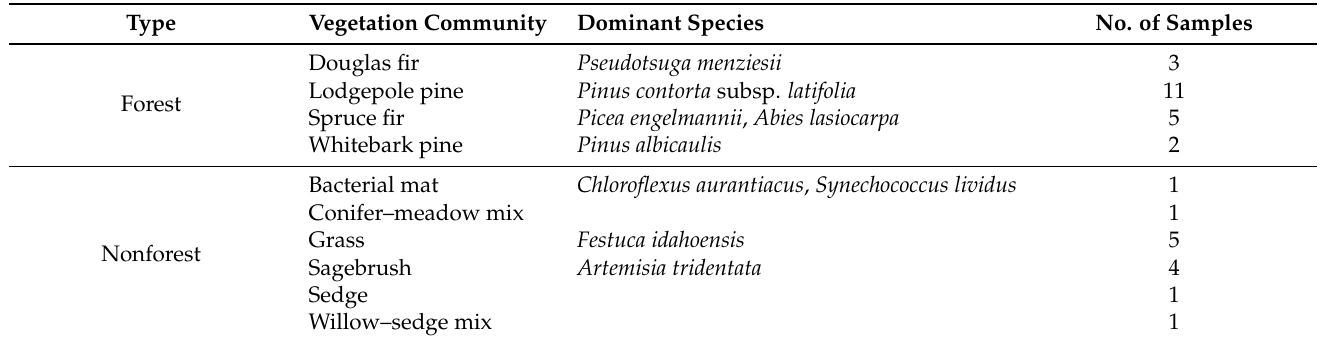
Table 1. Overview of vegetation samples used in the analysis. More detailed descriptions of the samples can be found in the USGS spectral library